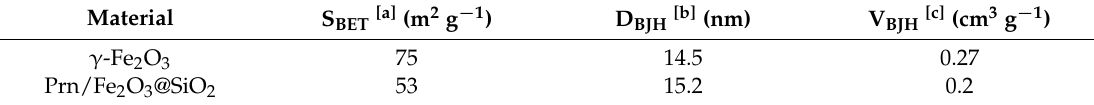
Figure 3. ( a ) Thermogravimetric (TG) and differential thermogravimetric (DTA) analyses of Prn/Fe 2 O 3 @SiO 2 , ( b ) VSM diagram of γ -Fe 2 O 3 and Prn/Fe 2 O 3 @SiO 2 , ( c ) XRD pattern of γ -Fe 2 O 3 , γ -Fe 2 O 3 @SiO 2 -NH 2 and Prn/ Fe 2 O 3 @SiO 2 , ( d ) N 2 physisorption isotherms of γ -Fe 2 O 3 and Prn/Fe 2 O 3 @SiO 2 . Table 1. Textural properties.